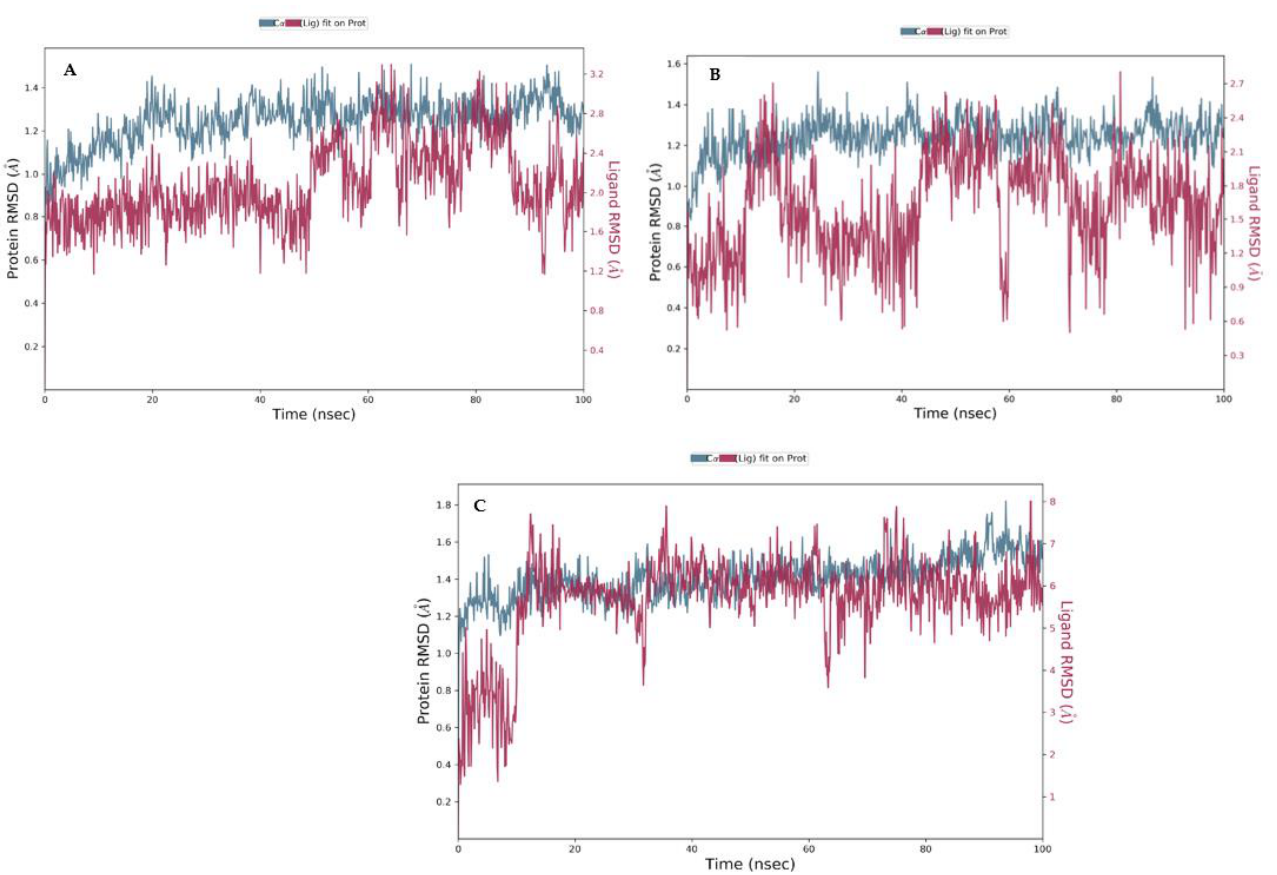
Figure 8. RMSD analyses for ( A ) native inhibitor (myricetin); ( B ) compound 8 ; ( C ) acarbose with the alpha-amylase (PDB 4GQR) of MD simulation trajectory.